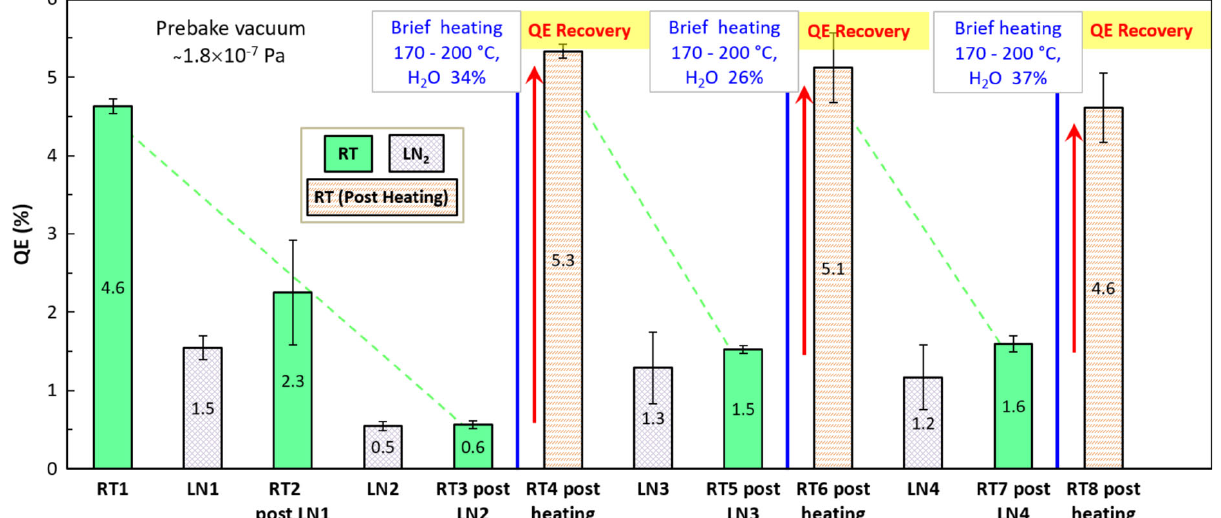
FIG. 1. Photocathode QE at 532 nm following successive iterations of sample cooling and heating inside the unbaked vacuum chamber. Note that QE did not restore following a return to room temperature, indicating that the vacuum conditions promoted surface contamination via gas adsorption. The blue text boxes indicate the temperature at which the sample was heated to rejuvenate the QE and the percentage increase in H 2 O partial pressure relative to the system total pressure during the brief heating period, as reported by the RGA.